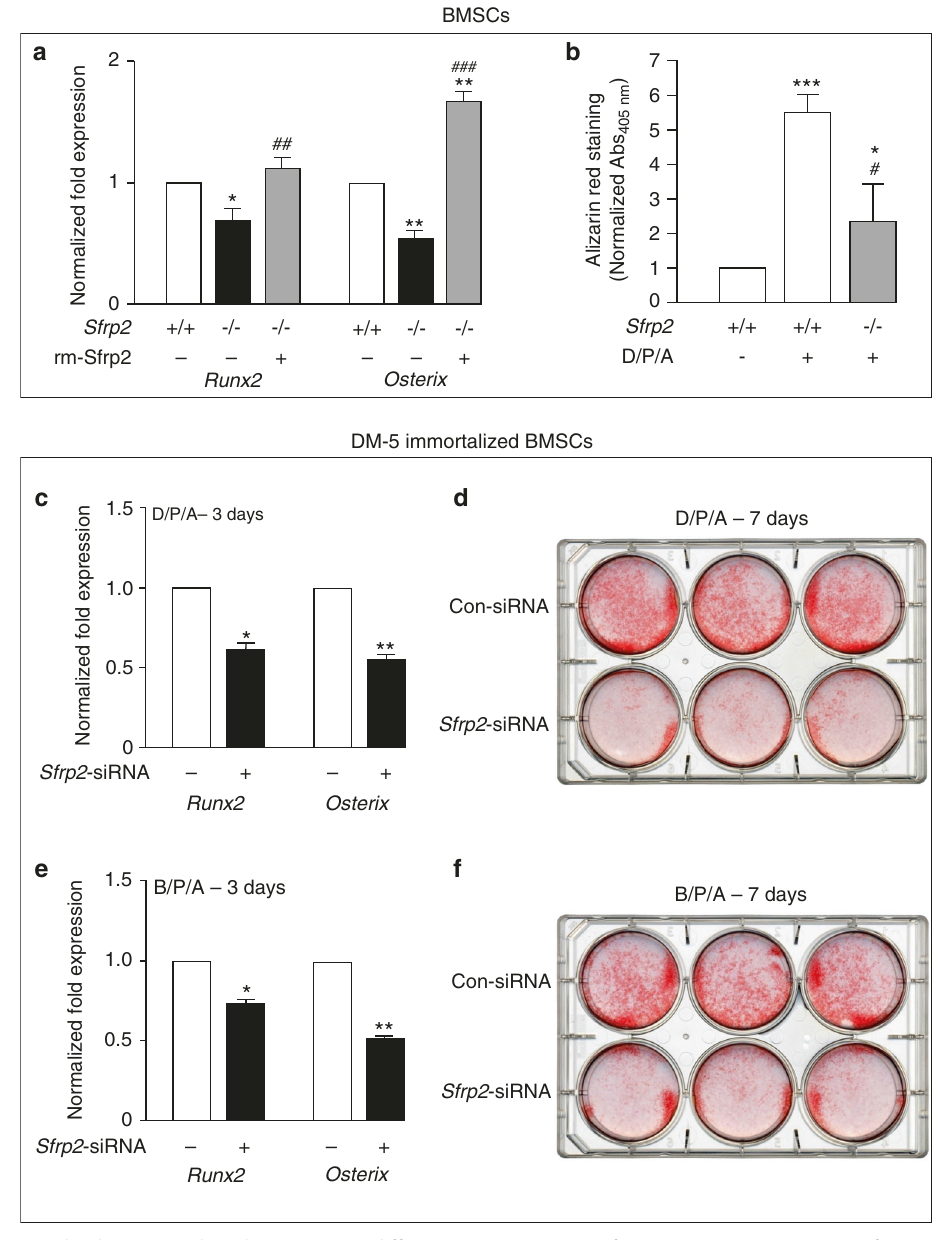
Fig. 5 Sfrp2 de fi ciency leads to a reduced osteogenic differentiation capacity of BMSCs/SSCs in vitro. a After 3 days of osteogenic differentiation with dexamethasone, β -glycerol phosphate and L-ascorbic acid 2-phosphate (D/P/A), Sfrp2 KO BMSCs/SSCs showed less expression of Runx2 and Osterix (vs. Gapdh ) than WT BMSCs/SSCs. Addition of exogenous rm-Sfrp2 (1 μ g·mL − 1 ) normalized Runx2 expression, and increased Osterix expression above WT levels. b After 21 days of osteogenic differentiation (D/P/A), Sfrp2 KO BMSC/SSC cultures were less mineralized than WT cultures, as measured by alizarin red S staining and absorptiometry at 405 nm. * P < 0.05; ** P < 0.01; *** P < 0.01 vs. WT BMSCs/SSCs; # P < 0.05; ## P < 0.01; ### P < 0.01 vs. Sfrp2 KO BMSCs/SSCs . c – f DM-5, an immortalized BMSC/SSC line that retains the ability to form an ectopic ossicle upon transplantation, was transfected with scrambled (Con-siRNA) or Sfrp2 -siRNA. After 3 days of osteogenic differentiation with either D/P/A in ( c ), or BMP-2, β -glycerol phosphate and L-ascorbic acid 2-phosphate (B/P/A) in ( e ), cells silenced for Sfrp2 expression showed decreased expression of Runx2 and Osterix (vs. Gapdh ). After 7 days of osteogenic differentiation with D/P/A or B/P/A, cells silenced for Sfrp2 expression showed decreased calcium accumulation as shown in alizarin red S stains in ( d , f ). Data represent mean ± SD. * P < 0.05; ** P < 0.01 vs. Con-siRNA-treated